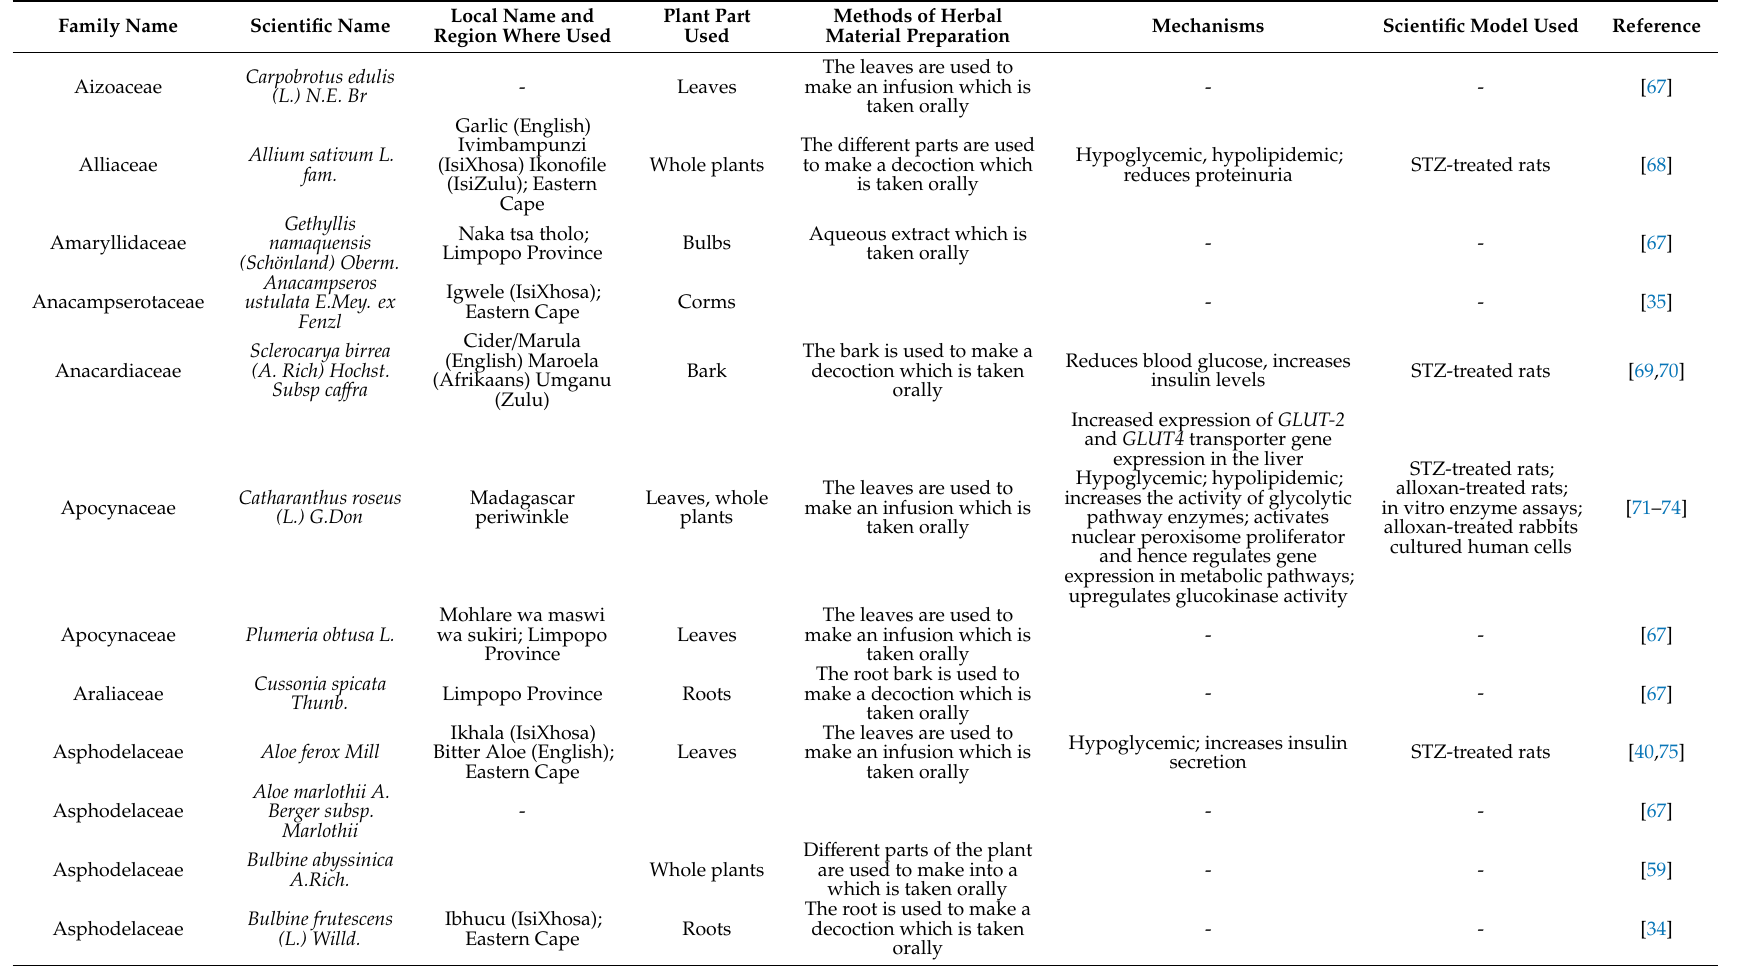
Table 2. List of plants used for the treatment of diabetes mellitus in South